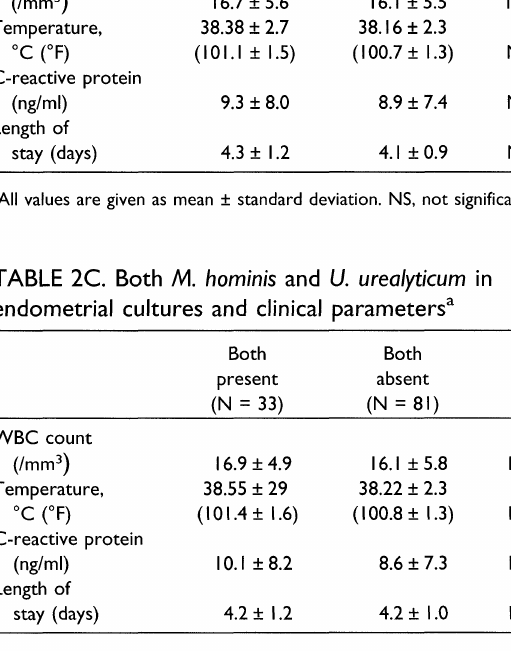
TABLE 2B. U. urealyticum in endometrial cultures and clinical parameters u. urealyticum